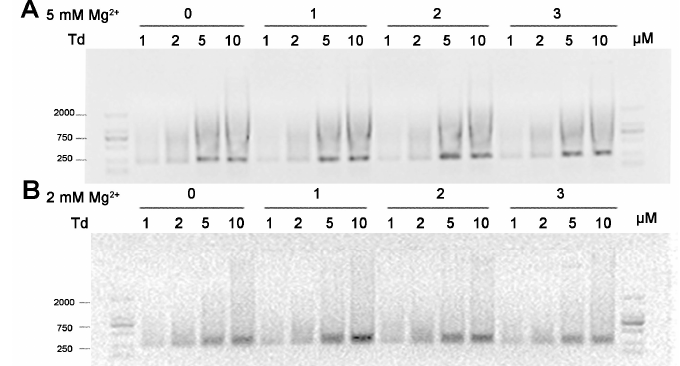
Figure 4. The influence of the freezing-thawing step on the stability of Td structure. Agarose gel of 1, 2, 5 or 10 μM Td prepared in buffers containing either 5 mM ( A ) or 2 mM ( B ) Mg 2+ , after repeated freeze-thawing processes. Numbers on the top line indicate the times of freeze-thawing.